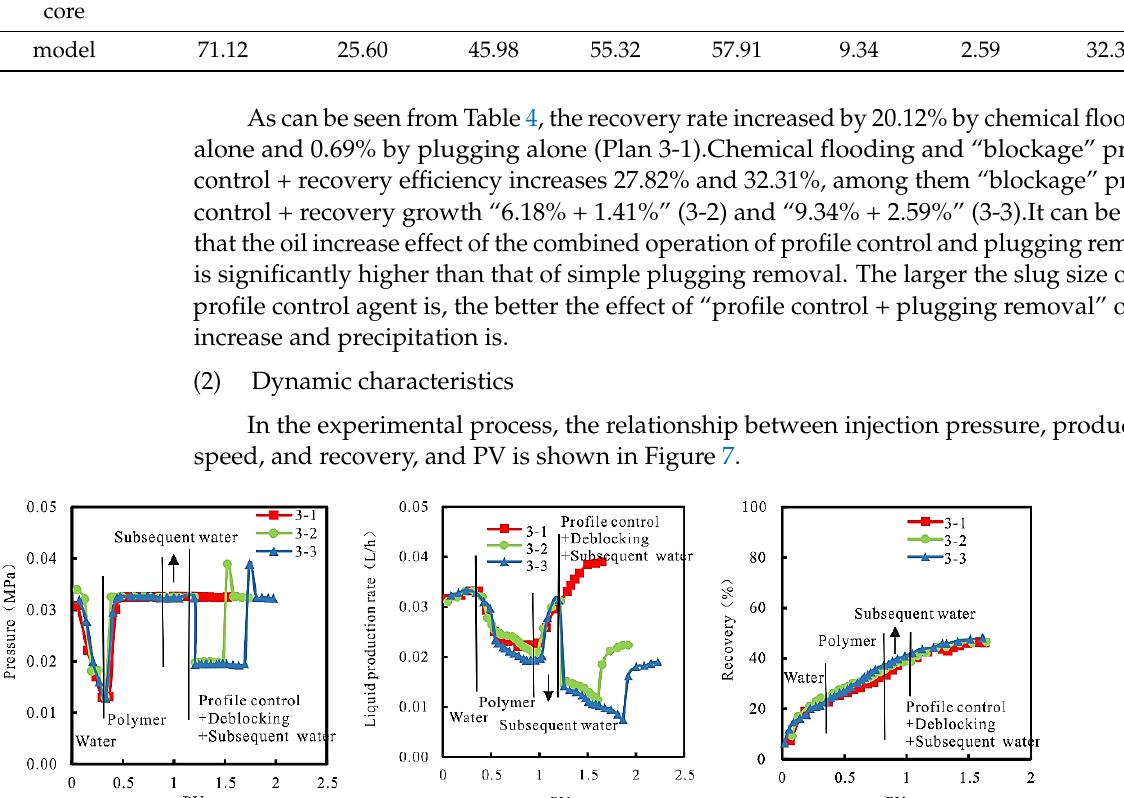
Table 4. Experimental data on oil-increasing and precipitation effect of the chemical flooding model “profile control + plugging removal” of recovery factor.